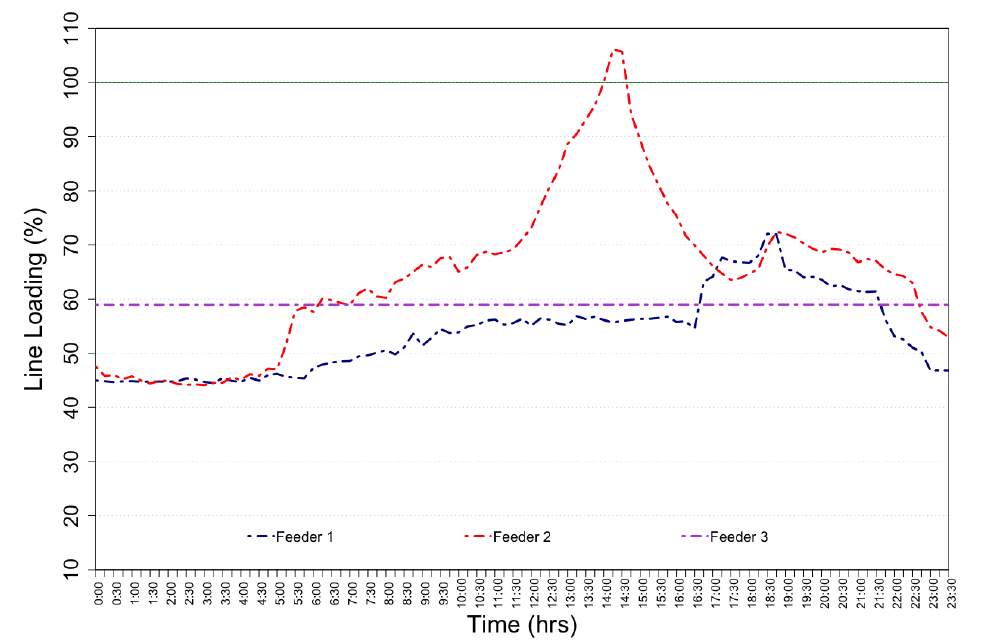
Figure 3. DR event due to line loading violation at Feeder 2.